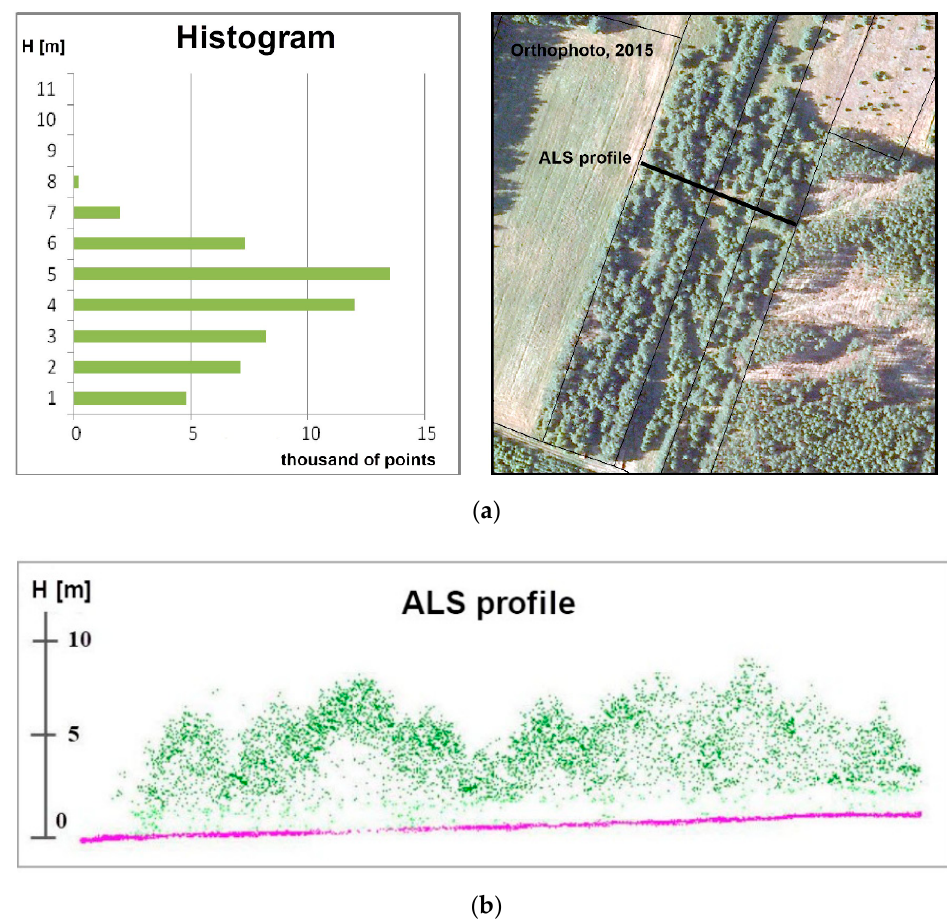
Figure 10. Precise information about vegetation: ( a ) histogram; ( b ) profile from ALS point clouds. For the whole analyzed area, a map of height changes (increase in height of vegetation) from 2007–2015 was prepared. In Figure 11 some parts of this map can be observed, as an illustration of the detailed information that can be obtained about the forest succession